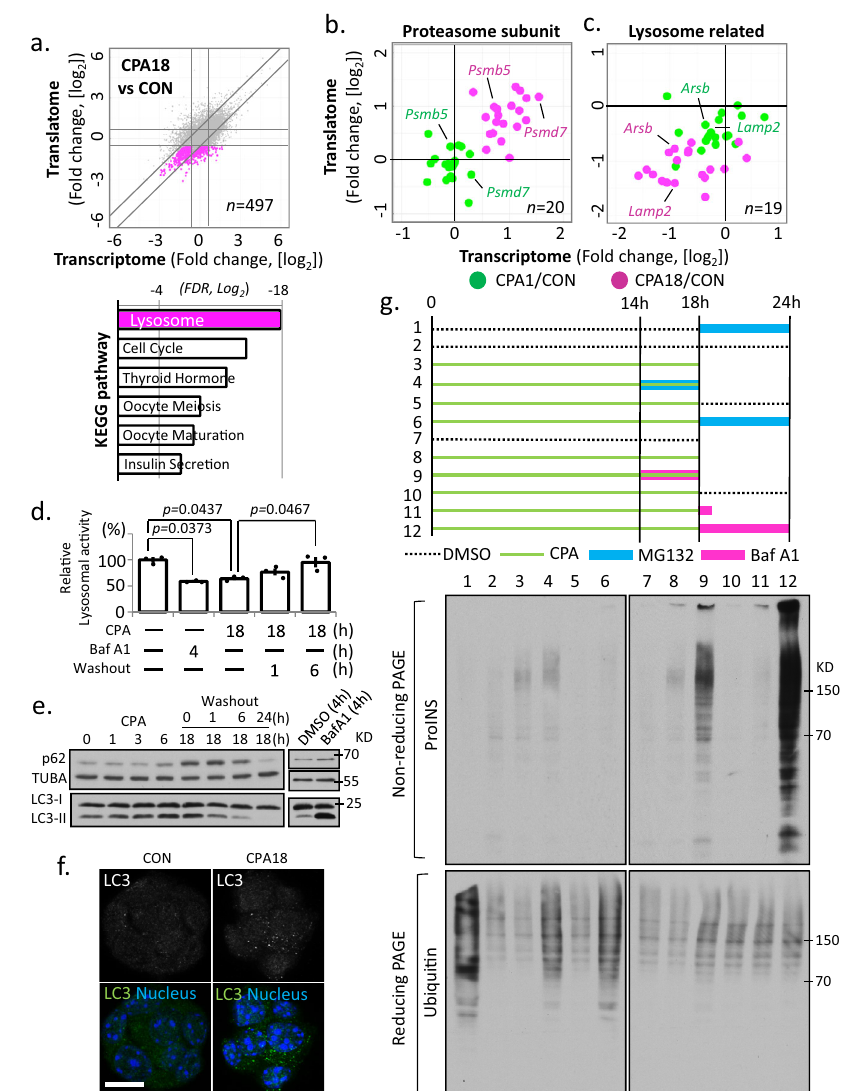
Fig. 5 | Impairment of lysosome activity correlates with misfolded proinsulin accumulationduringchronicERstress.a ScatterplotoffoldchangesinCPA18vs CON MIN6 cells, with the repressed gene expression indicated in pink, and the KEGG pathway analysis of the highlighted group, below a . Scatterplots of fold change in acute (CPA1/CON) and chronic (CPA18/CON) ER stress for genes related to the proteasome ( b ) and the lysosome ( c ). d lysosome enzymatic activity mea- sured in MIN6 cells treated with Baf A1 or CPA. n =3 independent experiments. Error bars represent S.E.M. p -value represents the statistical test by two-tailed paired Student ’ s t -test. Source data are provided as a Source Data fi le. e Western